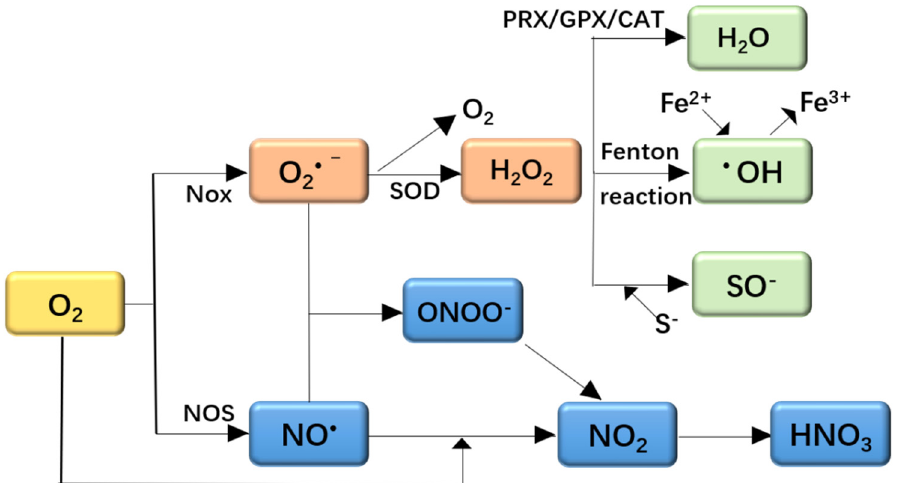
Figure 1. ROS and oxidative stress. NOX, NADPH oxidase family; ROS, reactive oxygen species; NOS, nitric oxide synthase; SOD, superoxide dismutase; PRX, peroxiredoxin; CAT, catalase; GPX, glutathione peroxidase; H 2 O 2 , hydrogen peroxide; ·OH, hydroxide radicals.